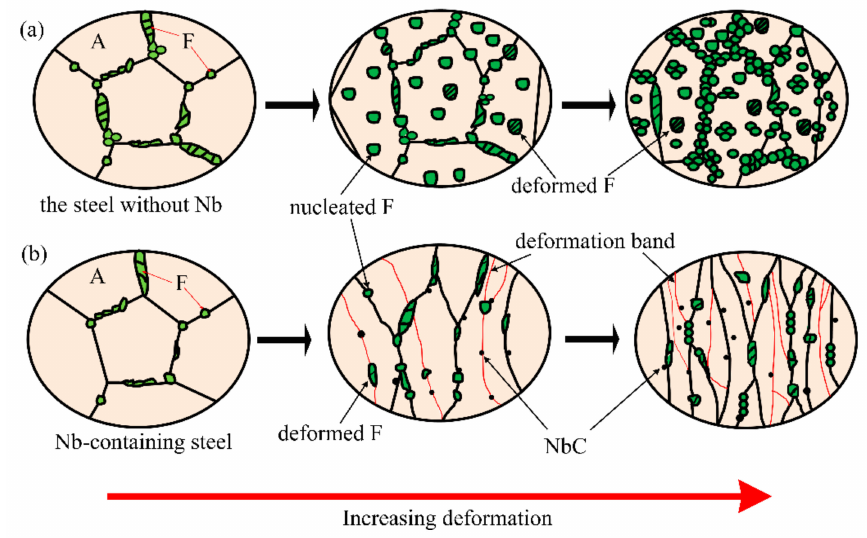
Figure 14. Schematic diagrams of microstructural evolution during deformation. ( a ) Based on the microstructural evolution data of experimental steel without Nb element in Reference [39]. ( b ) Nb-containing steel of the 650 ◦ C